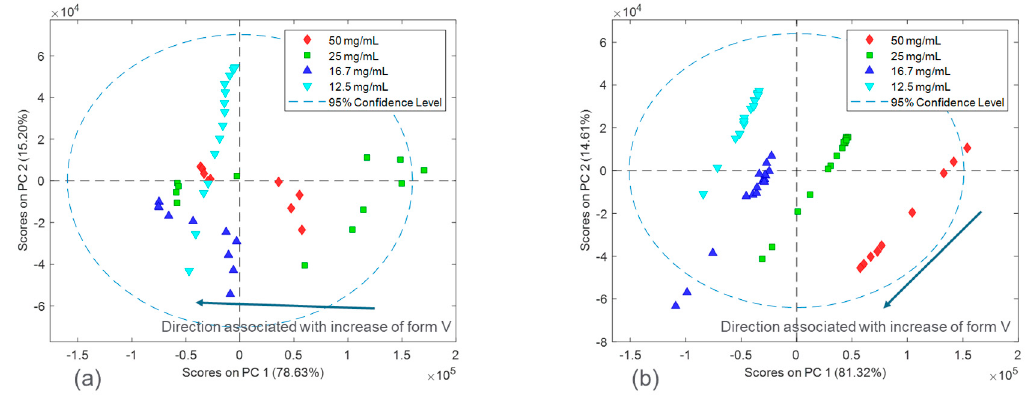
Figure 6. PCA scores of the calibration sets for HCl salt ( a ) and maleate salt ( b ).